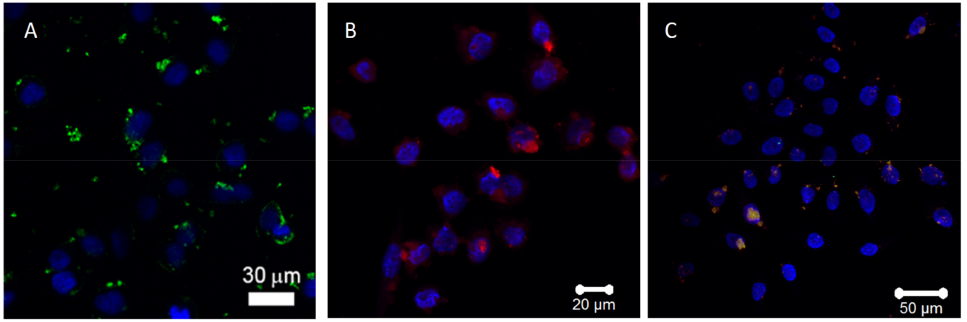
Figure 3. Laser scanning microscopy (LSM) images of PC-3 cells that were QD-labeled with HNTs-Azine-CdS ( A ), HNTs-NH 2 -CdS ( B ), and HNTs-Azine-Cd 0.7 Zn 0.3 S ( C ). The nuclei were stained with DAPI (blue channel, 405-nm laser), QD are shown in green (488-nm laser) and red channel (543-nm